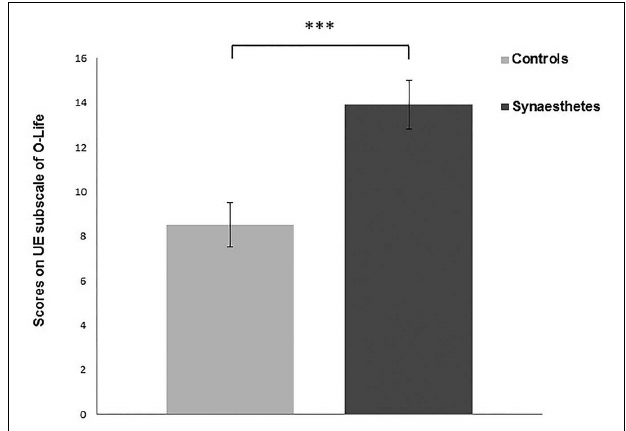
FIGURE 1 | Synaesthetes scored significantly higher on the Unusual Experiences (UEs) subscale of O-Life indicating greater positive